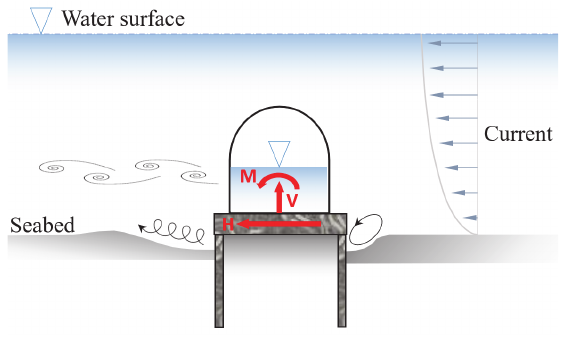
Figure 4. An underwater gas storage accumulator founded on a suction caisson transmitting V ‐ H ‐ M loading at the top of the foundation. (H: horizontal load; V: vertical load; M: moment